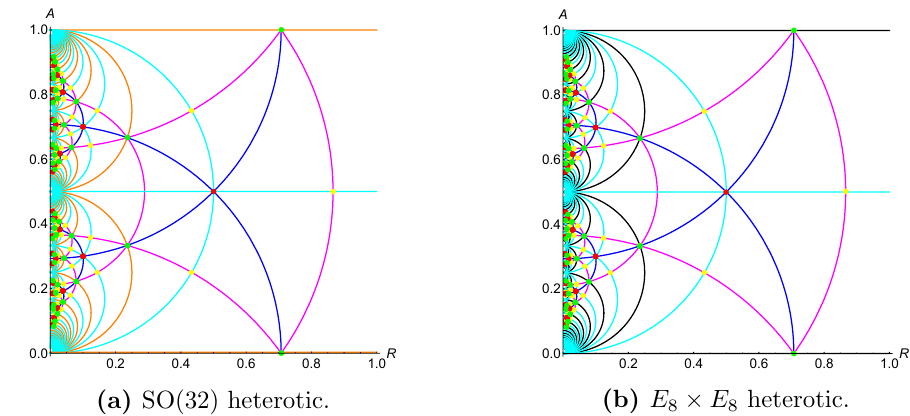
Figure 7. Enhancement groups on the left sector of the heterotic theory on the slice of moduli space de(cid:12)ned by A; R , with Wilson line A I = ( A; 0 7 ; A + 1 ; 0 7 ). See table 3 for details.